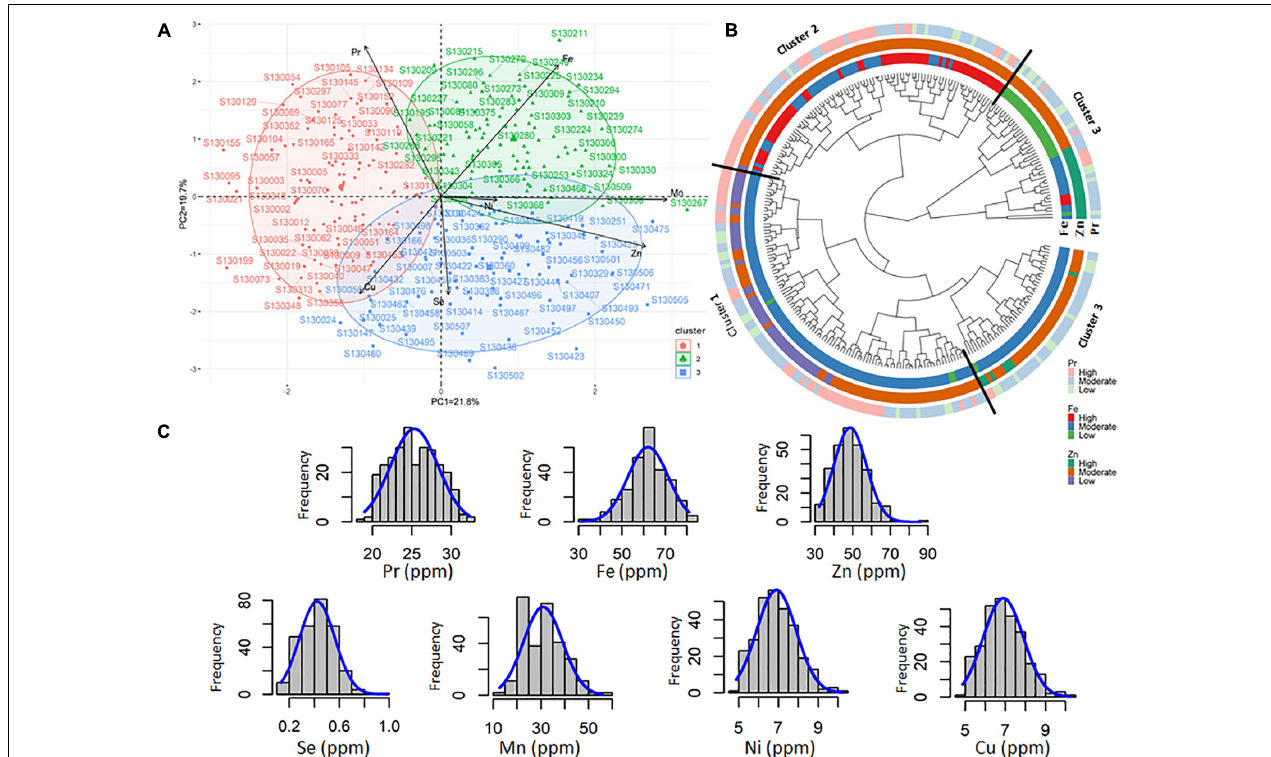
FIGURE 4 | (A) Biplot of the first two dimensions of the PCA. (B) Dendrogram showing the list of genotypes grouped in each cluster with the level of micronutrients. (C) Normal distribution and frequency different tested genotypes and their content in protein (Pr), concentrations of iron (Fe), zinc (Ze), selenium (Se), manganese (Mn), nickel (Ni), and copper